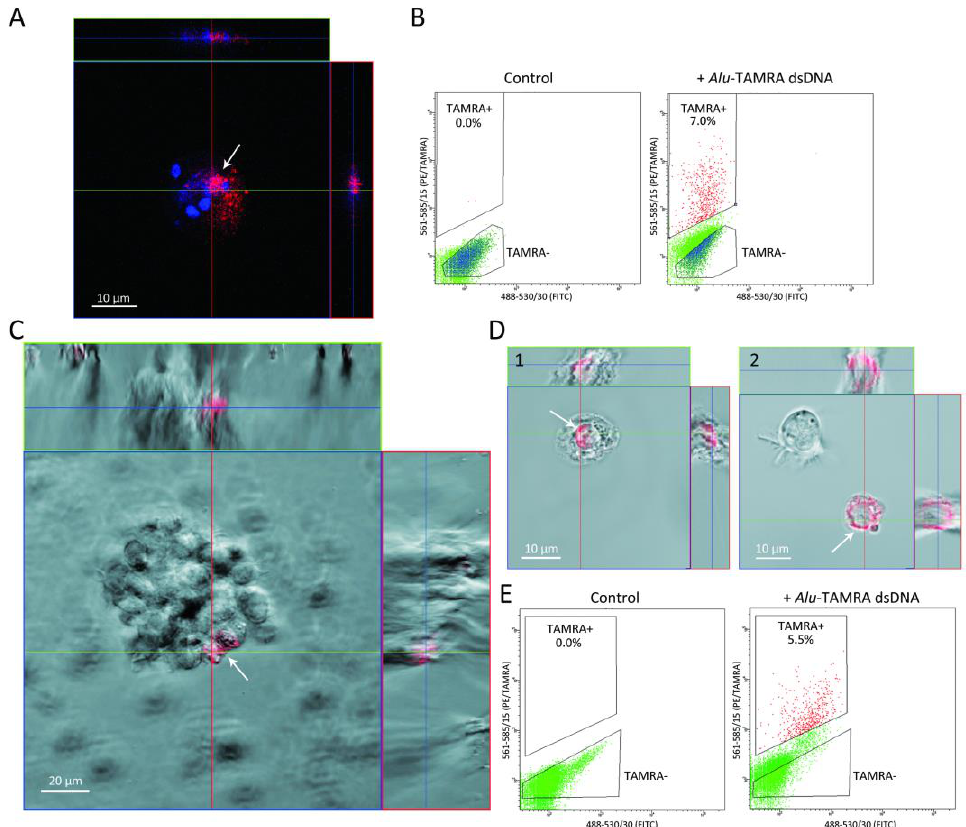
Figure 1. Alu -TAMRA dsDNA internalization into murine carcinoma Krebs-2 cells and human EBV- Induced B-cell lymphoma (HH47). ( A ) Orthogonal projections of Krebs-2 cells after incubation with the TAMRA dsDNA probe. ( B ) FACS assay of intact Krebs-2 cells (left panel) and those incubated with the Alu -TAMRA dsDNA probe (right panel). Orthogonal projections of the HH47 sphere ( C ) and individual cells ( D ) were produced using an LSM 780 NLO laser scanning microscope (Zeiss). The TAMRA signal corresponds to exogenous Alu -dsDNA residing inside the nucleus (1) or in the cytoplasm (2) of the cell. The X and Y views are shown on the right and top parts of the images, and the Z-plane projections are shown in the center. ( E ) FACS assay of the intact HH47 cells (left panel) and those incubated with the Alu -TAMRA dsDNA probe (right panel). All imaging procedures are described in detail in ref. [2]. The TAMRA signal (red) is shown by arrows.